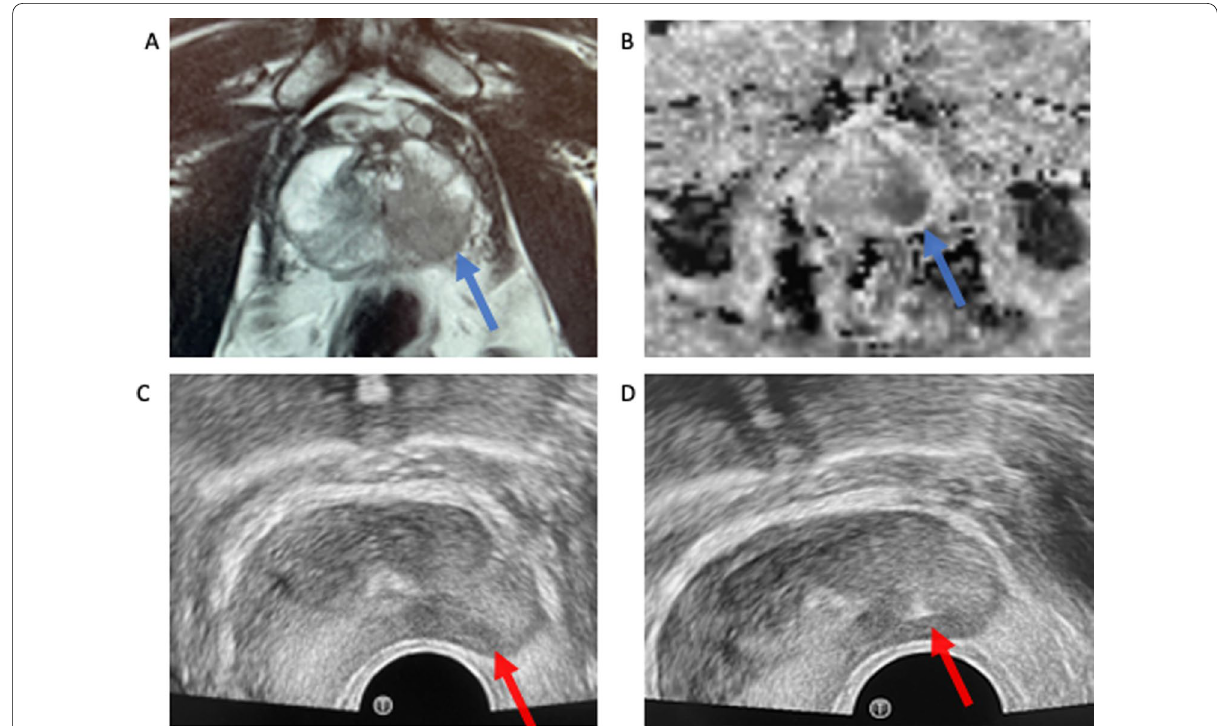
Fig. 14 A and B show a PIRADS 5 lesion within the left mid peripheral zone on T2-weighted imaging and the associated ADC map. C shows the correlate identified at the time of ultrasound with D confirming needle position within the targeted lesion